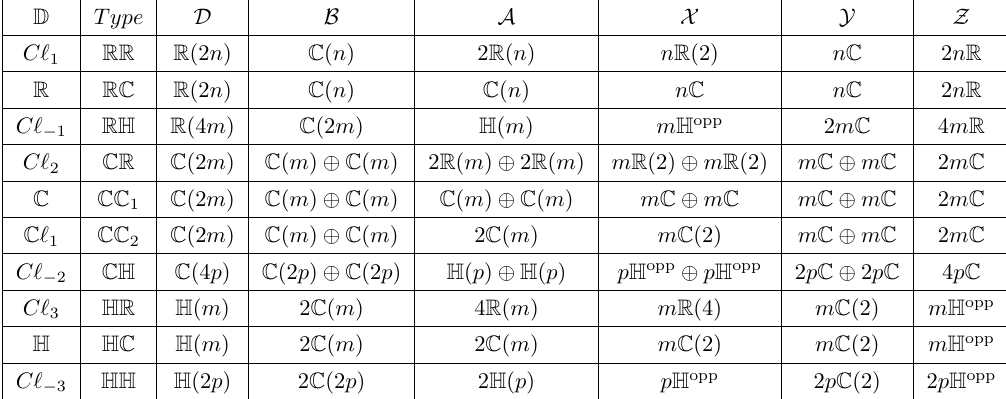
Table 1 . The real division superalgebras matched with the Dyson Types and their Dyson triples. The first column will be explained below — it is one the main points of this paper. We have defined a map from φ -irreps to the Dyson